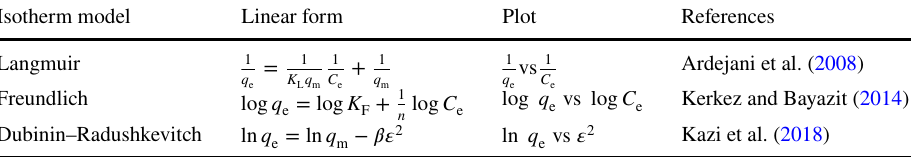
Table 2 Linear equations of isotherm models